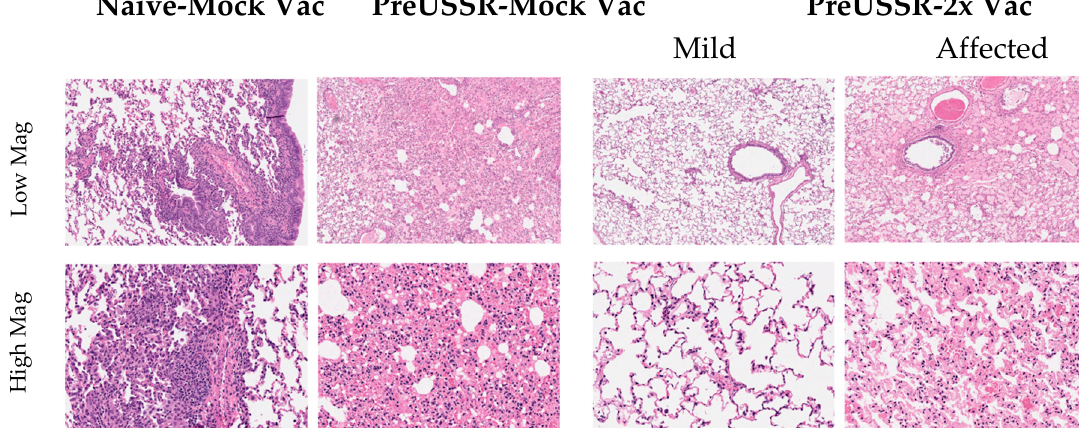
Figure 3. Viral shedding following challenge was lower in previously infected and vaccinated ferrets. Nasal washes were collected from all groups Day 2 p c (Cal/09). Live viral load was calculated by TCID 50 titration assay using MDCK cells. Student’s t -tests were performed among groups to determine statistical significance. ** indicates a p -value of less than 0.001.